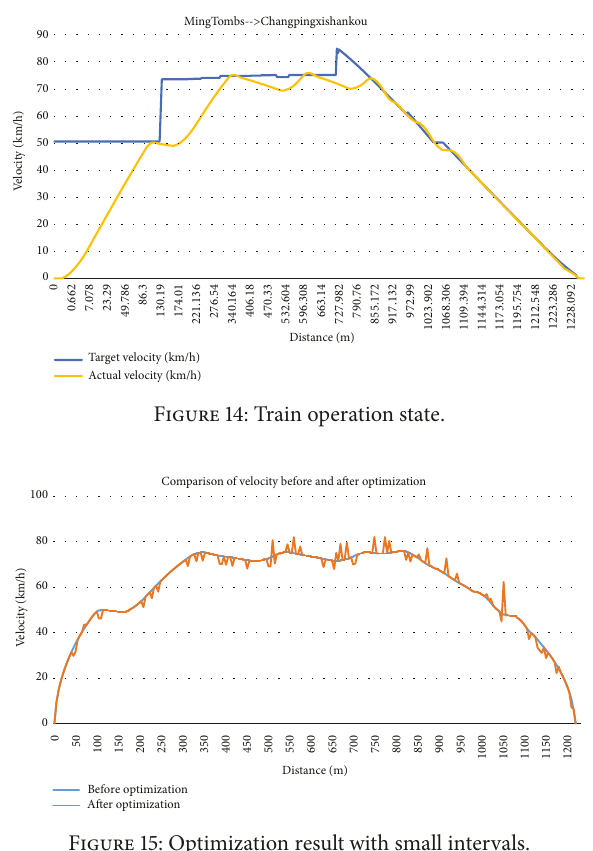
Figure 15: Optimization result with small intervals.